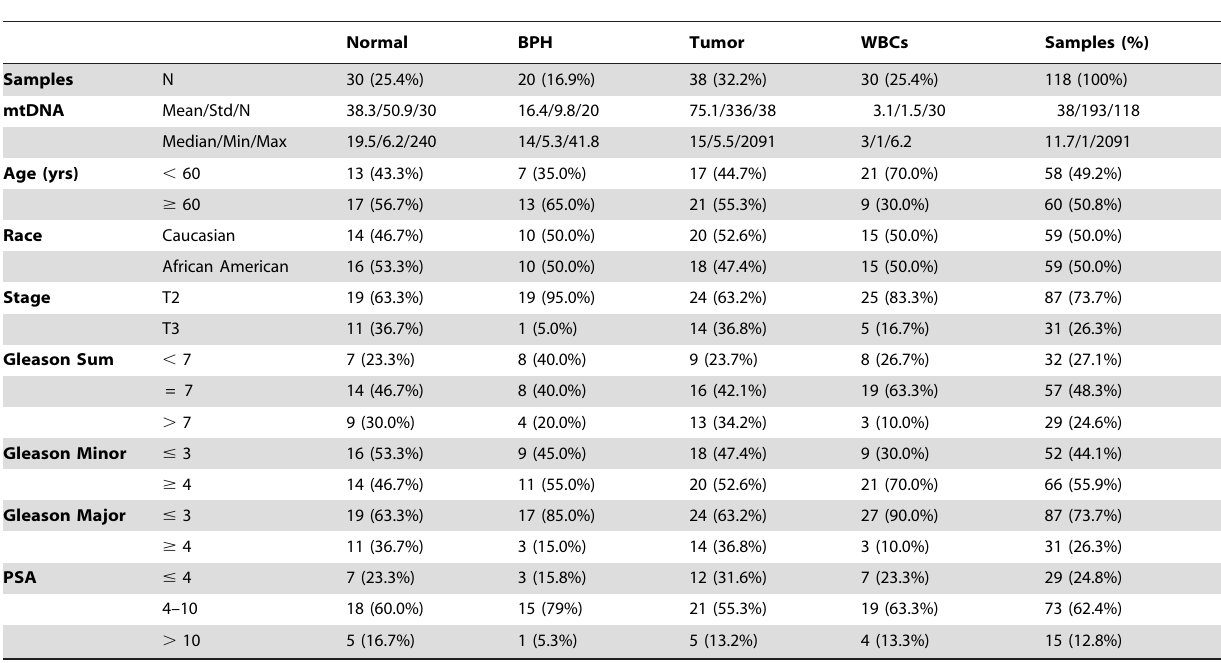
Table 1. Demographic and clinical analysis of mtDNA content in prostate cancer among American men.